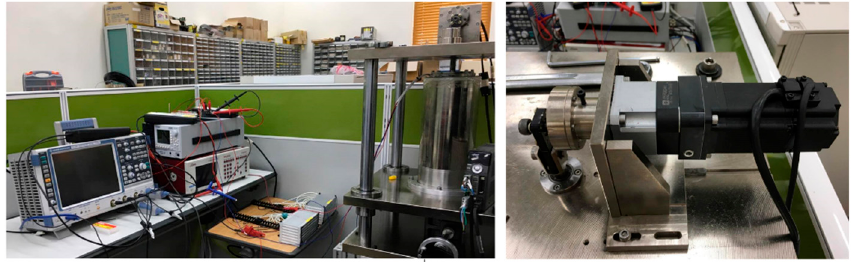
Figure 4. Experimental installment.